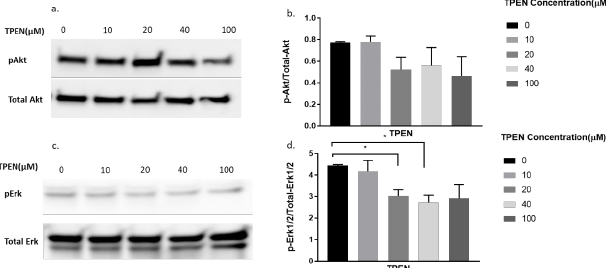
Figure 4. Western blot result of pAkt and pErk in C2C12 cells treated with increasing concentrations of TPEN. ( a , c ). Cells were treated with increasing concentrations of TPEN (0, 10, 20, 40, 100 µM) for 60 min followed by 30 min of 10 nM insulin treatment before harvesting total protein. Phosphorylated Akt and Erk were immunoprobed by Western blotting. Total Akt and Total Erk were used as internal controls. Three independent Western blots on three independent treatments were performed. ( b , d ). Densitometry graphs for pAkt and pErk, respectively, from three independent Western blots * = p < 0.05.